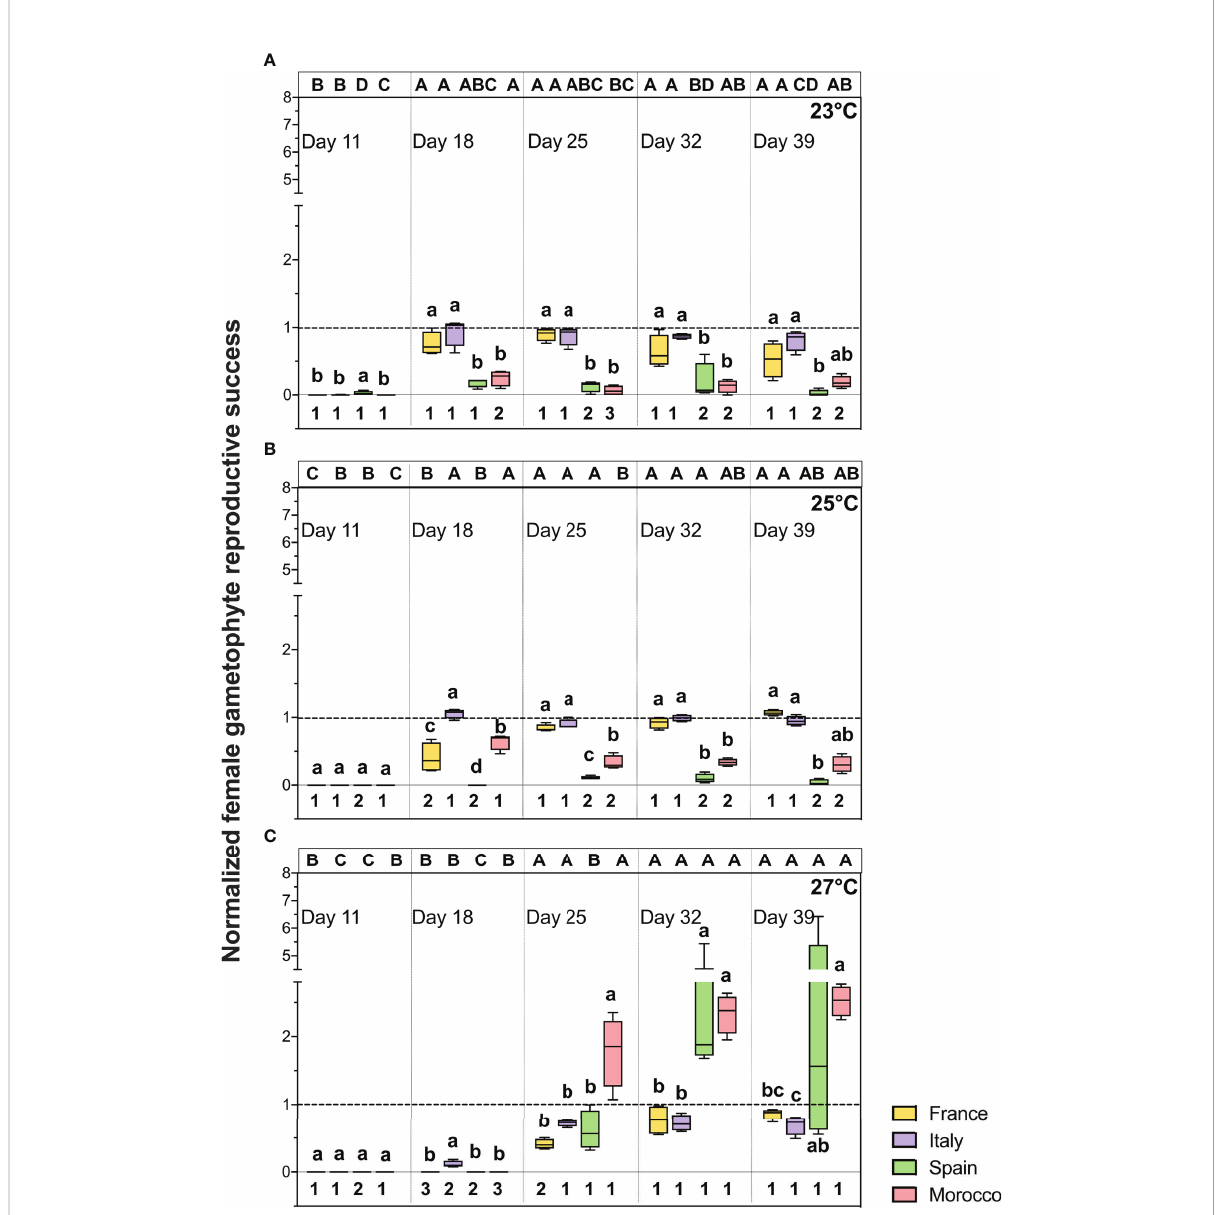
FIGURE 5 Female gametophyte reproductive success (proportion of female gametophytes with eggs and sporophytes) of different populations of Laminaria ochroleuca over recovery (day 39) at 17°C from MHW treatments of 23°C (A) , 25°C (B) and 27°C (C) . Note that the female reproductive values were normalized to the control treatment (17°C) value for each population (dotted line). Box plots with median, boxes for 25 th and 75 th percentiles and whiskers indicating min and max values (n = 4). For each temperature and time period, different lowercase letters above boxplot bars indicate signi fi cant differences between populations. For each population and temperature, different uppercase letters indicate differences between time periods. For each population and time period, different numbers indicate differences between temperatures ( p < 0.05). See Table 4 for statistical